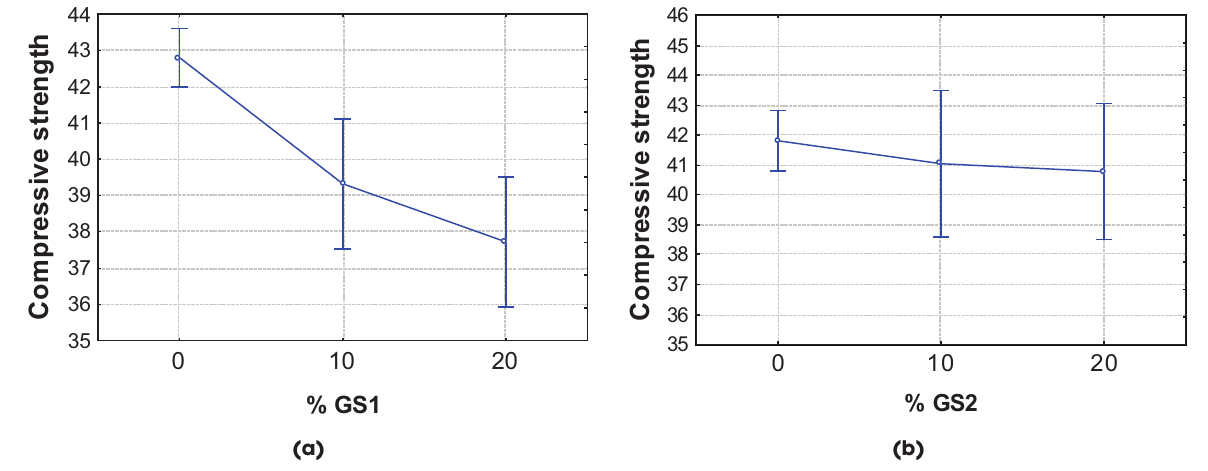
Statistical analysis of concrete with glass wastes. (a) mixtures with GS1 (b) mixtures with